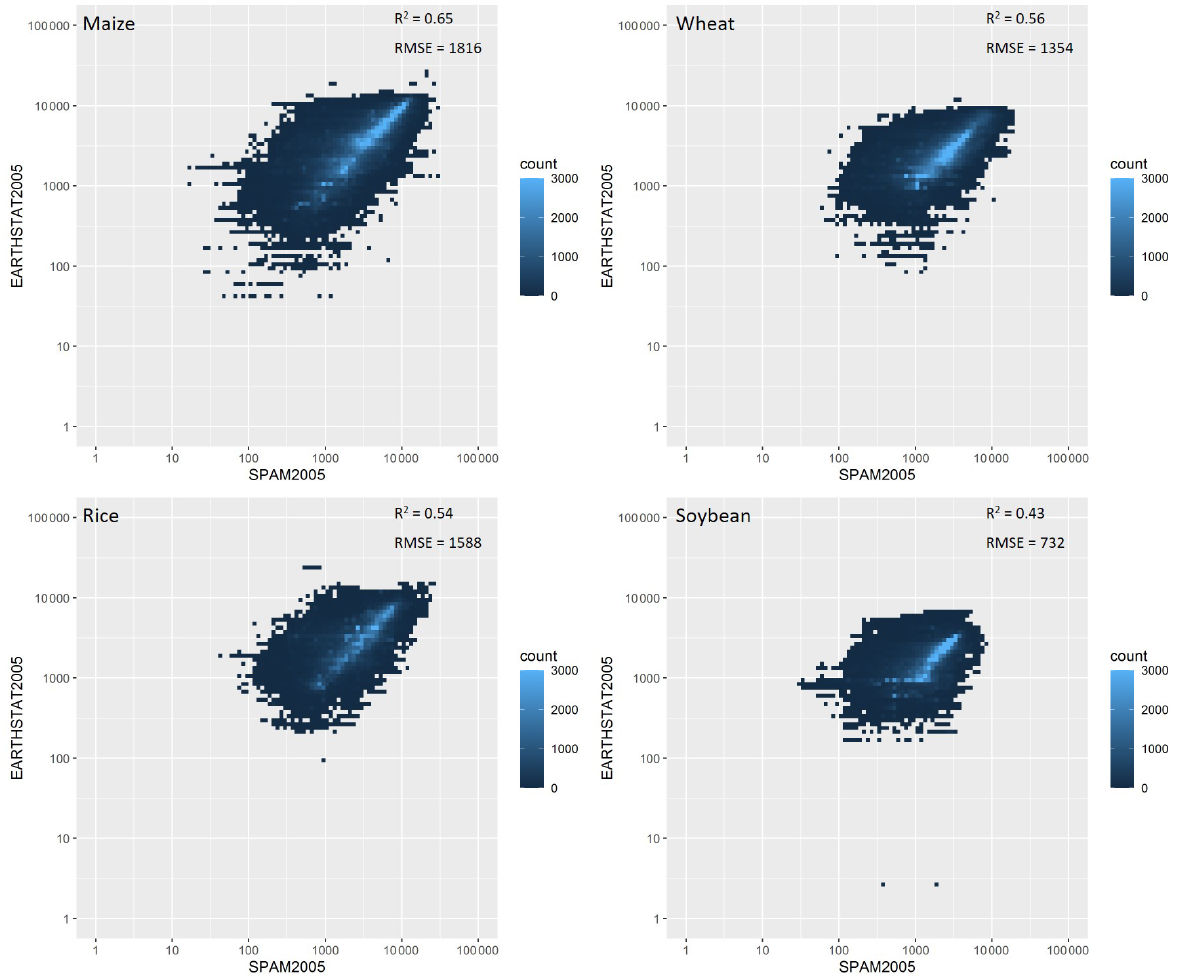
Figure 12. Grid-by-grid comparison between SPAM2005 and EARTHSTAT2005 in crop yields. (log–log scale plot; unit: kg / ha).